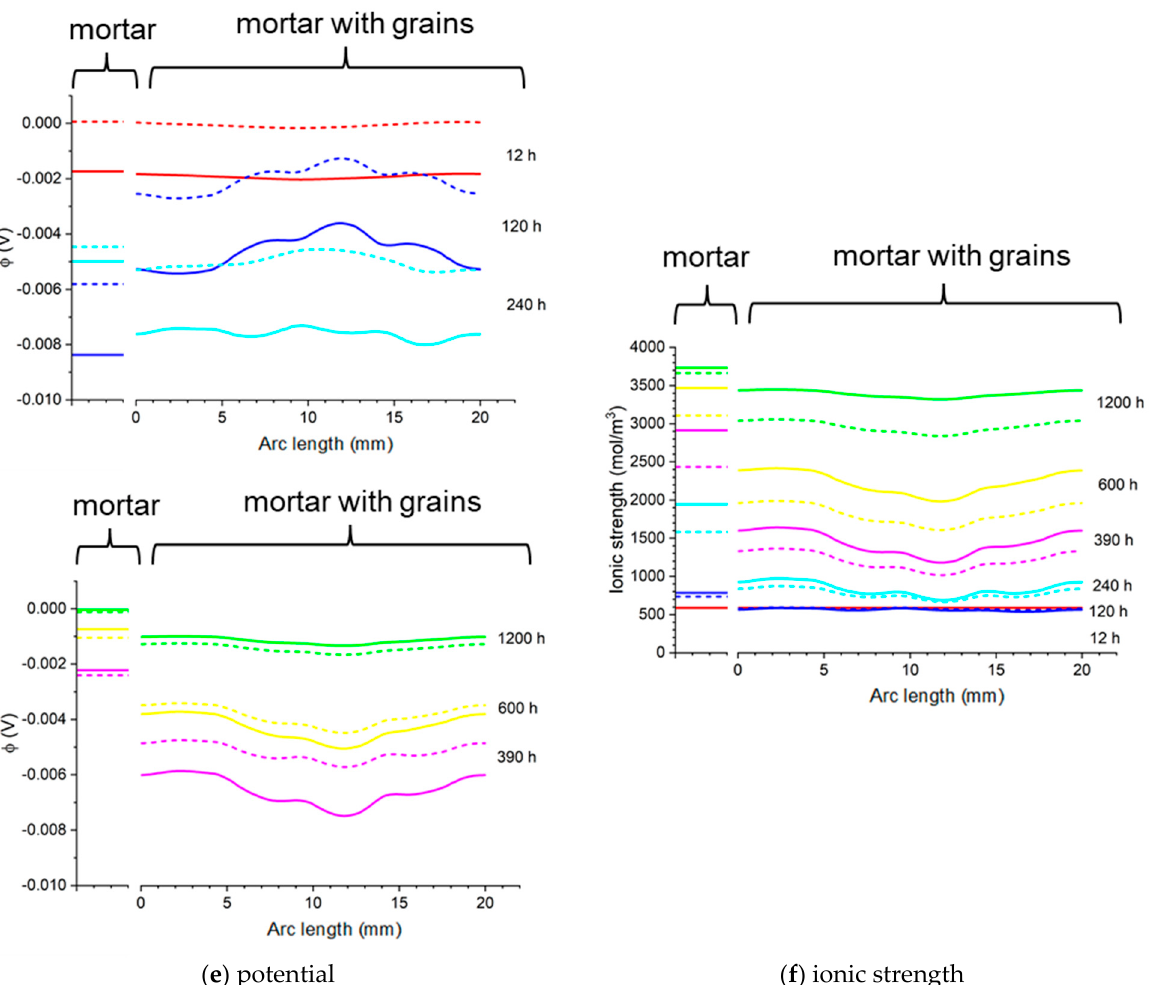
Figure 25. Calculated: ion concentrations: ( a ) Na + , ( b ) Cl − , ( c ) K + , (d) OH − , ( e ) potential ( φ ), and ( f ) ionic strength in the mortar and concrete samples at the surface of the rod in 20% NaCl water solution (along a blue line). Solid lines correspond to the solution for the Pitzer activity model and dashed lines are the solution neglecting activities ( γ = 1